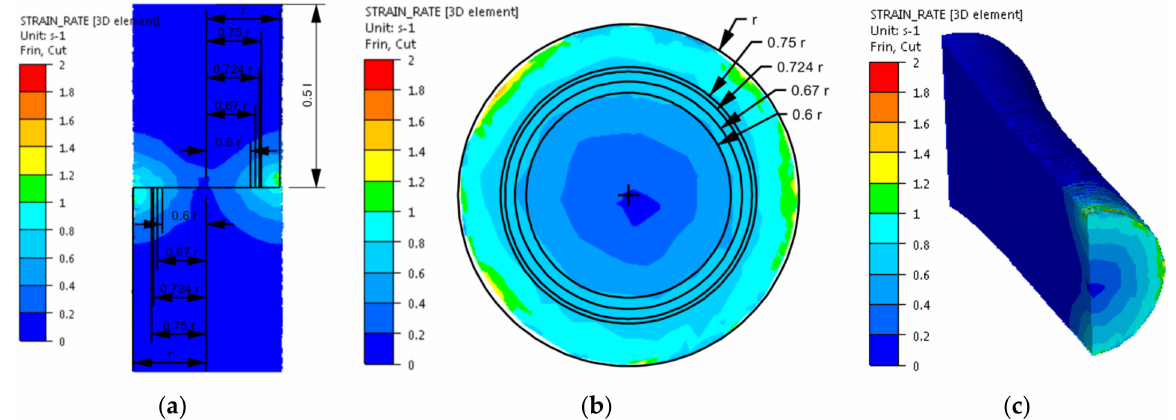
Figure 8. Distribution of the strain rate intensity of the 5019 aluminium alloy calculated numerically using coefficients from Table 1: ( a ) longitudinal section, ( b ) cross-section—centre of the working part and ( c ) perspective.